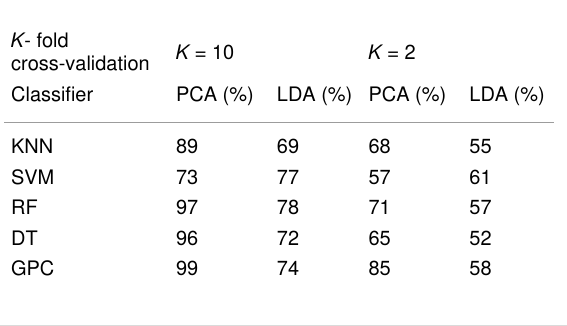
Table 2: Gas classification rate.